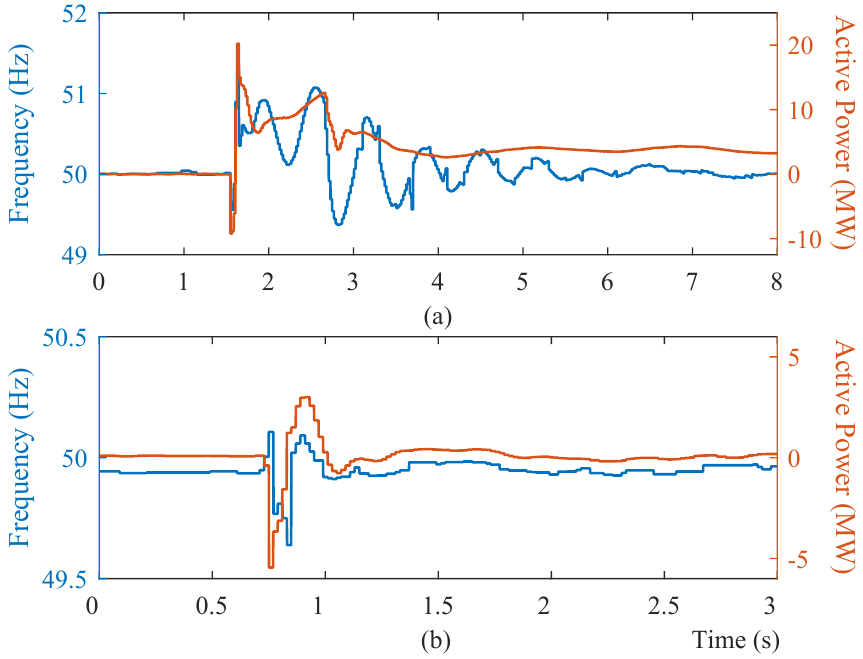
Figure 12. Frequency support of Dalrymple to system events: ( a ) Single phase to ground fault at the Ardrossan West–Dalrymple 132 kV line. ( b ) Single phase to ground fault at the Bungama–Blyth West 275 kV line (plots drawn with data from